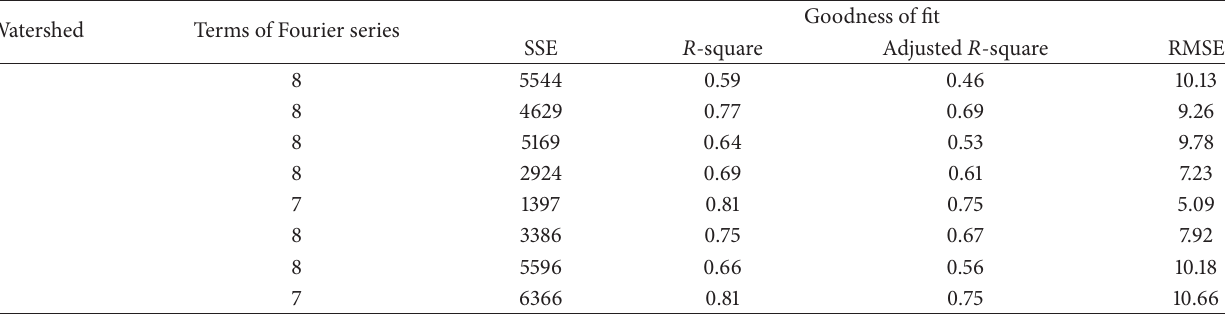
Table 4: Goodness of fit of fitted smooth curves for watersheds.